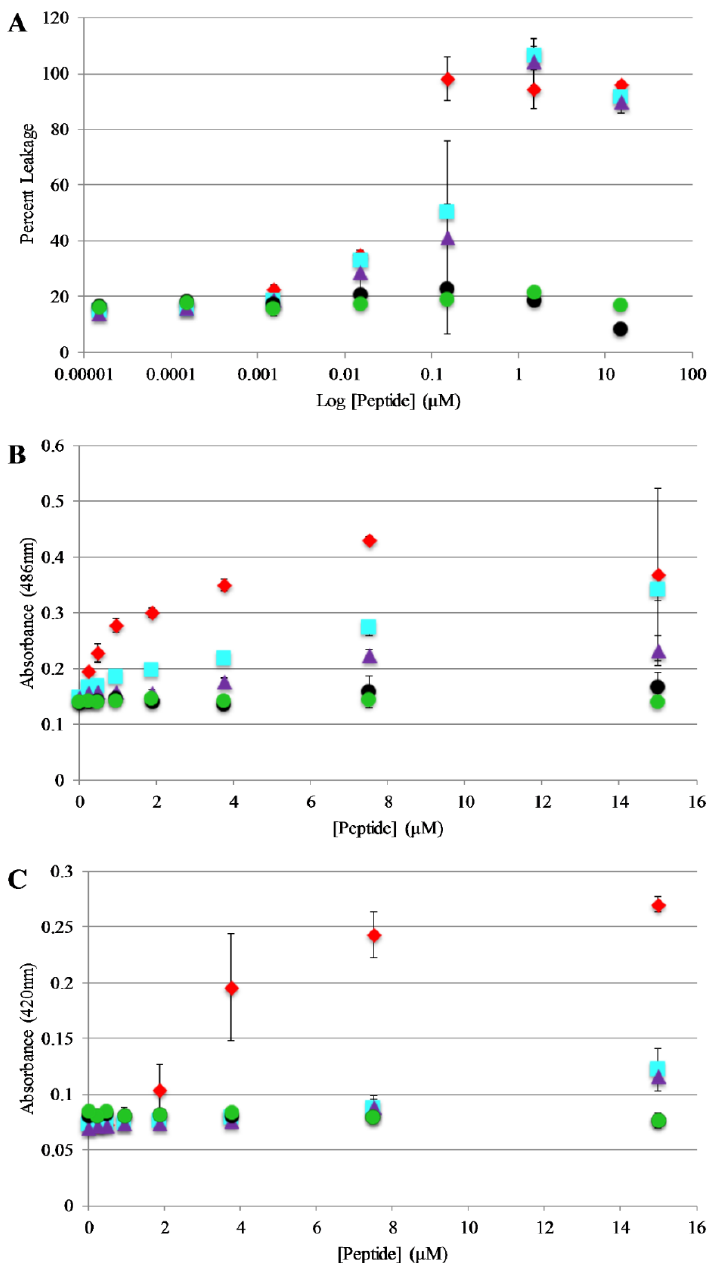
Figure 5. Vesicle and Bacterial permeabilization: ( A ) Leakage of calcein entrapped in 75:25 PC:PG lipid vesicles (200 µ M) after exposure to peptides. Percent leakage was calculated by treating each sample with Triton X-100 and remeasuring fluorescence which was then set to 100% leakage. ( B ) Outer membrane permeability of E. coli after treatment with peptides. Samples contained 50 µ g/mL nitrocefin, and 80 µ L of resuspended E. coli cell suspension, and 10 µ L peptide from a stock solution for the appropriate final concentration. Absorbance values shown represent data collected after 30 min of exposure to peptide. ( C ) Inner membrane permeability of E. coli after treatment with peptides. Samples contained 56.25 µ L Z-buffer (100 mM Na 2 HPO 4 , 10 mM KCl, 1 mM MgSO 4 , 40 mM β -mercaptoethanol, pH 7.1), 12 µ L ortho-Nitrophenyl- β -galactoside (ONPG) (4 mg/mL), 18.75 µ L E. coli , (5.0 × 10 5 cfu/mL) and 10 µ L of peptide from the appropriate final concentrations. Absorbance values shown represents data collected after 30 min of exposure of peptide. For all graphs AP3 is shown as red diamonds, AP3K as blue squares, APX as purple triangles, APX-17 as black circles, and APX-12 as green circles. Data are averages of at least three replicate samples. Error bars represent the standard deviation of these data.